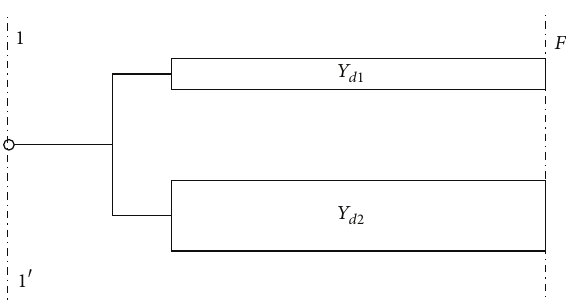
Figure 6: Equivalent network with electric and magnet wall.